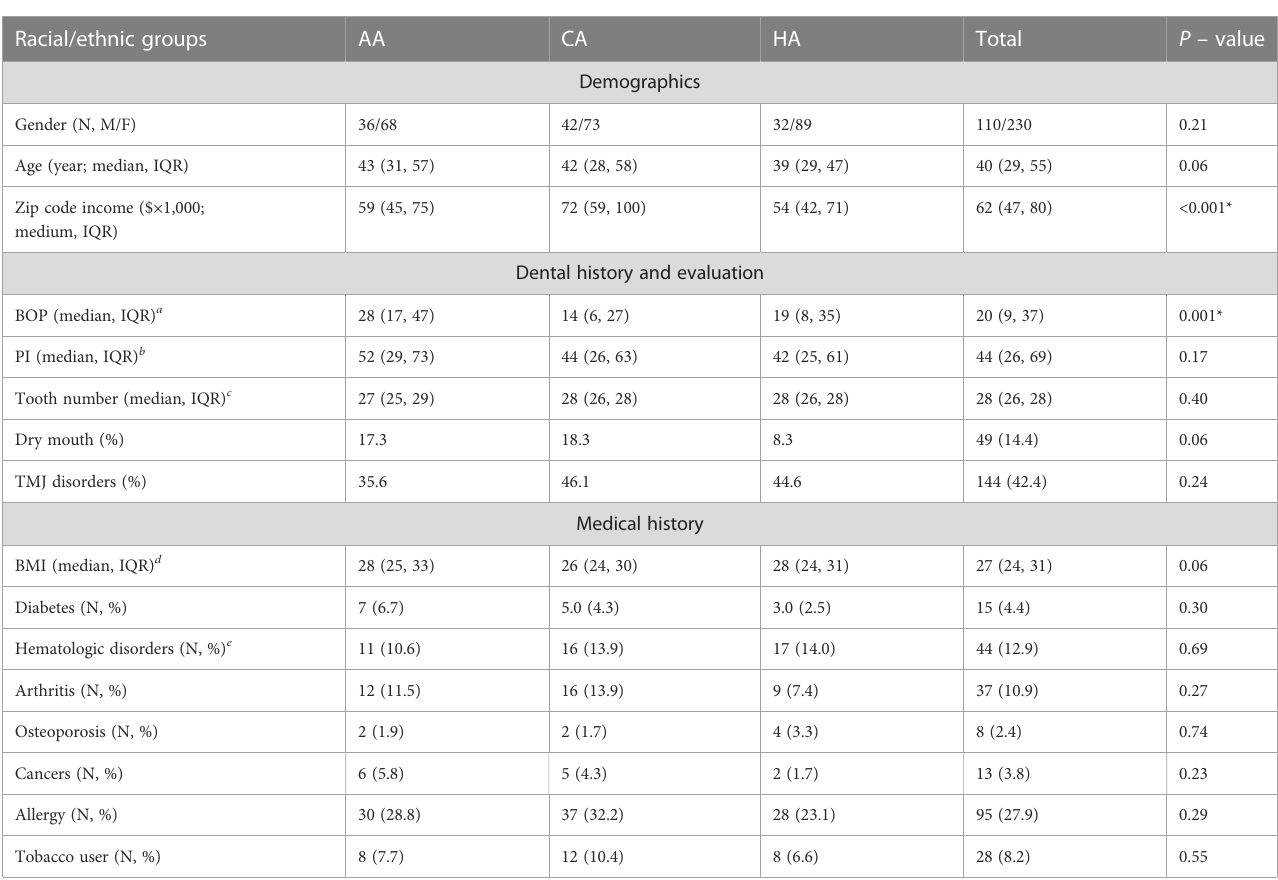
TABLE 2 Characteristics of the study cohort. Racial/ethnic groups